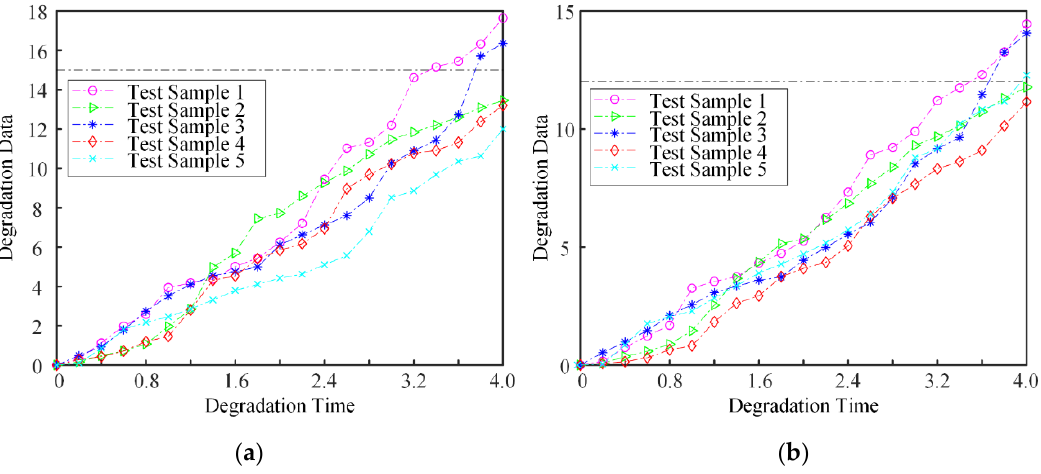
Figure 2. Degradation path for two performance indicators. ( a ) Degradation path for performance indicator 1; ( b ) Degradation path for performance indicator 2.